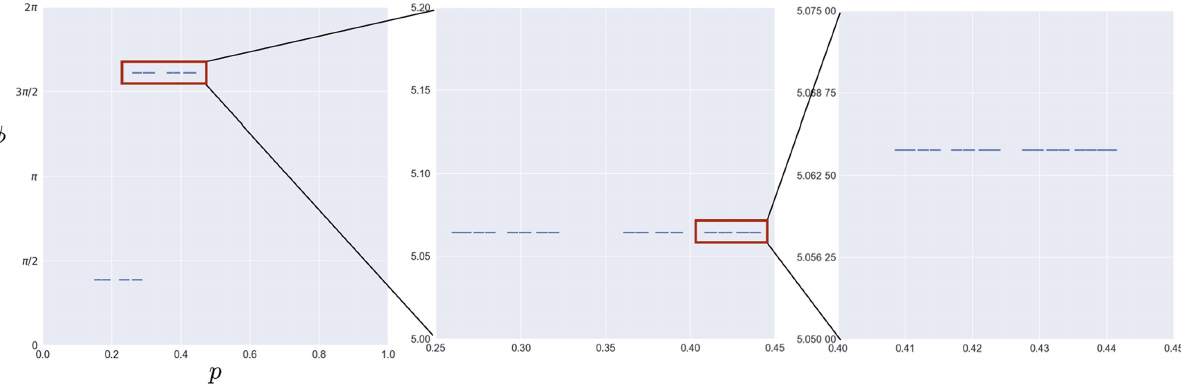
FIG. 9. Support of the geometric quantum state | GS ( N E ) (cid:3) for the ground state of the Heisenberg defect Hamiltonian with environ- ment size N = 22. The GQS has two separate islands with internal structure that is self-similar. In the left, middle, and right panels we progressively magnify the region around each part of the support to reveal the distribution’s self-similar support. In the thermodynamic limit its information dimension is estimated to be D ≈ 0.83 ±